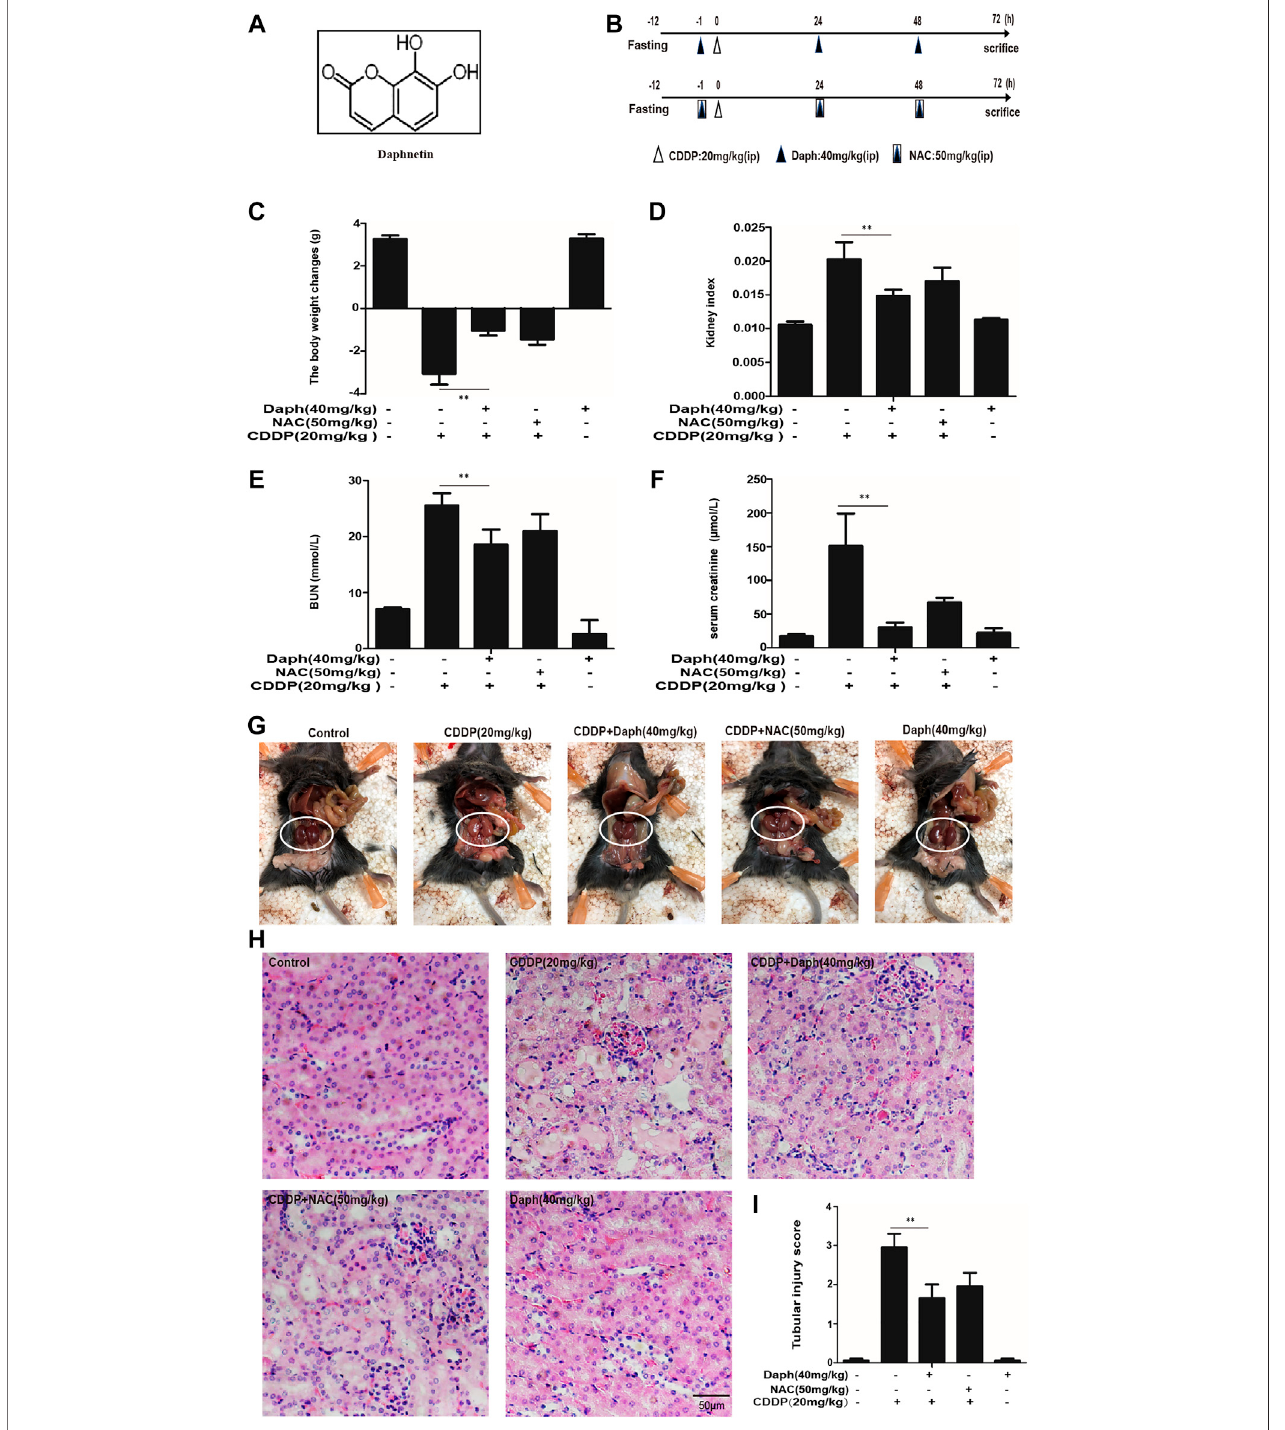
FIGURE 2 | Daph protects against CDDP-induced AKI in WT mice. (A) The molecular structure of Daph. (B) Schematic schedule for CDDP alone and combined with Daph or NAC treatments in vivo . Mice were treated with Daph (40 mg/kg) or NAC (50 mg/kg) once a day for three consecutive days. CDDP (20 mg/kg) was administered once at 1 h after the fi rst Daph or NAC injection. Mice were sacri fi ced at 72 h after the CDDP administration. (C) Body weight and (D) Kidney/body weight ratio. (E, F) BUN and serum creatinine were measured (G) macroscopic kidney and (H) hematoxylin and eosin (H&E). (I) Tubular injury scores for kidney damage. Data are presented as the mean ± SEM, n (cid:2) 5 for all test groups. * p < 0.05, ** p < 0.01.